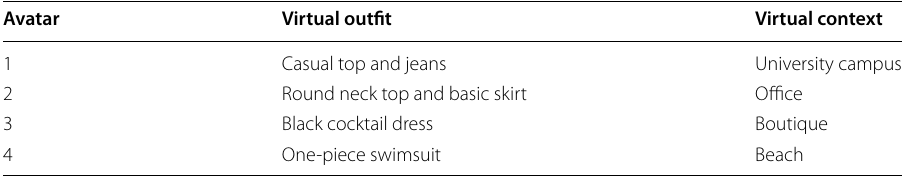
Table 1 Virtual outfit and context combinations for virtual avatar stimulus